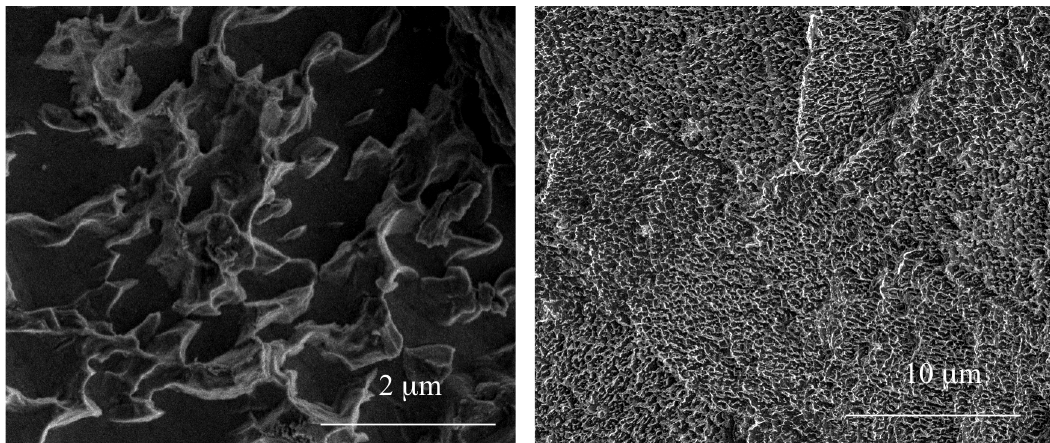
Figure 1. Scanning Electron Microscope (SEM) images of TiO 2 porous material (PTN) produced in the variable potential two step anodization process in ethylene glycol-based electrolyte obtained on Ti6Al4V alloy